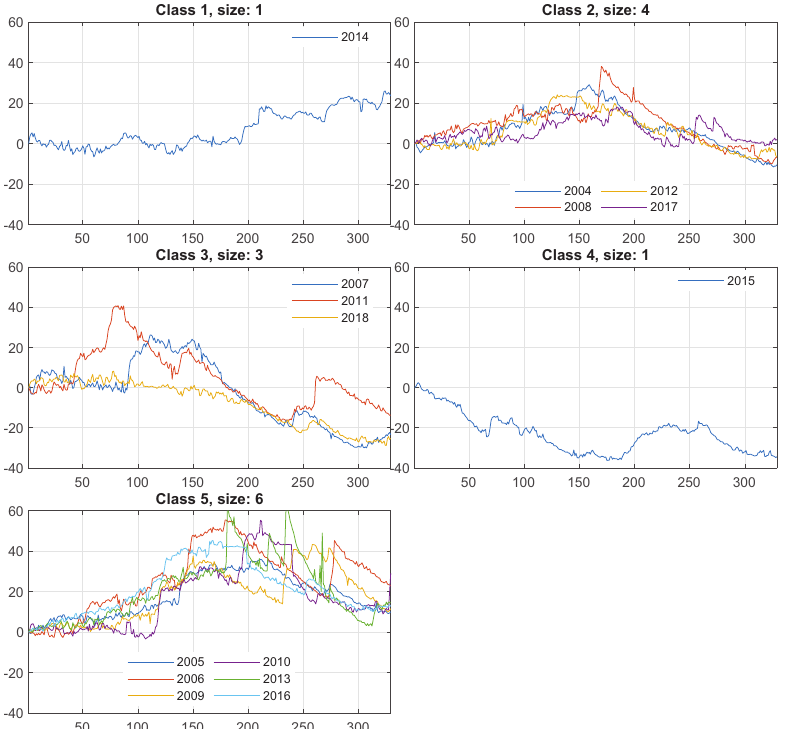
Figure 11. Dendrogram for time series of detrended groundwater levels corresponding to the HYs from applying the AHP clustering.